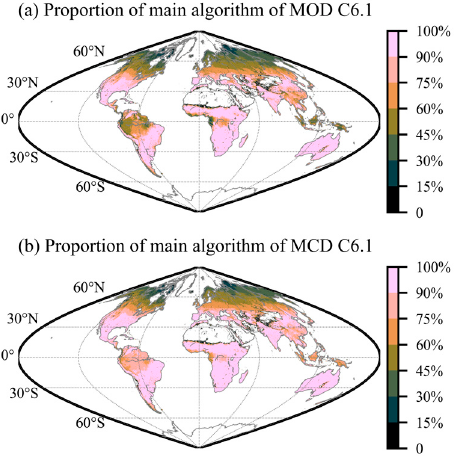
Figure 9. Proportion of LAI data retrieved from the main algorithm in 2003–2021 for ( a ) MOD15A2H C6.1 product, and ( b ) MCD15A2H C6.1 product.